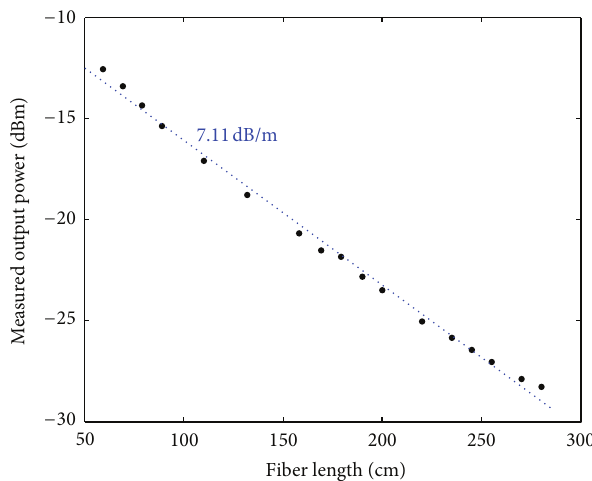
Figure 3: Attenuation coefficient measured on Yb 3+ /Er 3+ phosphate glass fiber obtained by exciting at 1300nm. After fitting the curve, a mean value of 7.11dB/m was found.